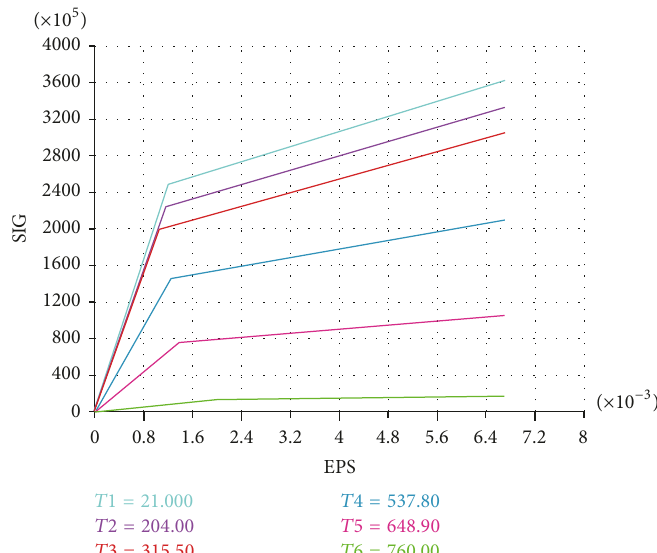
Figure3: Bilinearelastoplastic stress-strainproperties (SIG:stress,units:Pa; EPS:strain,dimensionless; 𝑇1∼𝑇6 :different temperatures, units: ∘